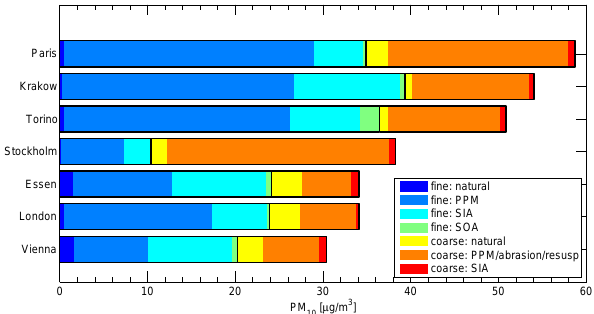
Figure 8. Modelled composition of PM 10 at seven monitoring sta- tions with different characteristics in the year 2009: chemical com-